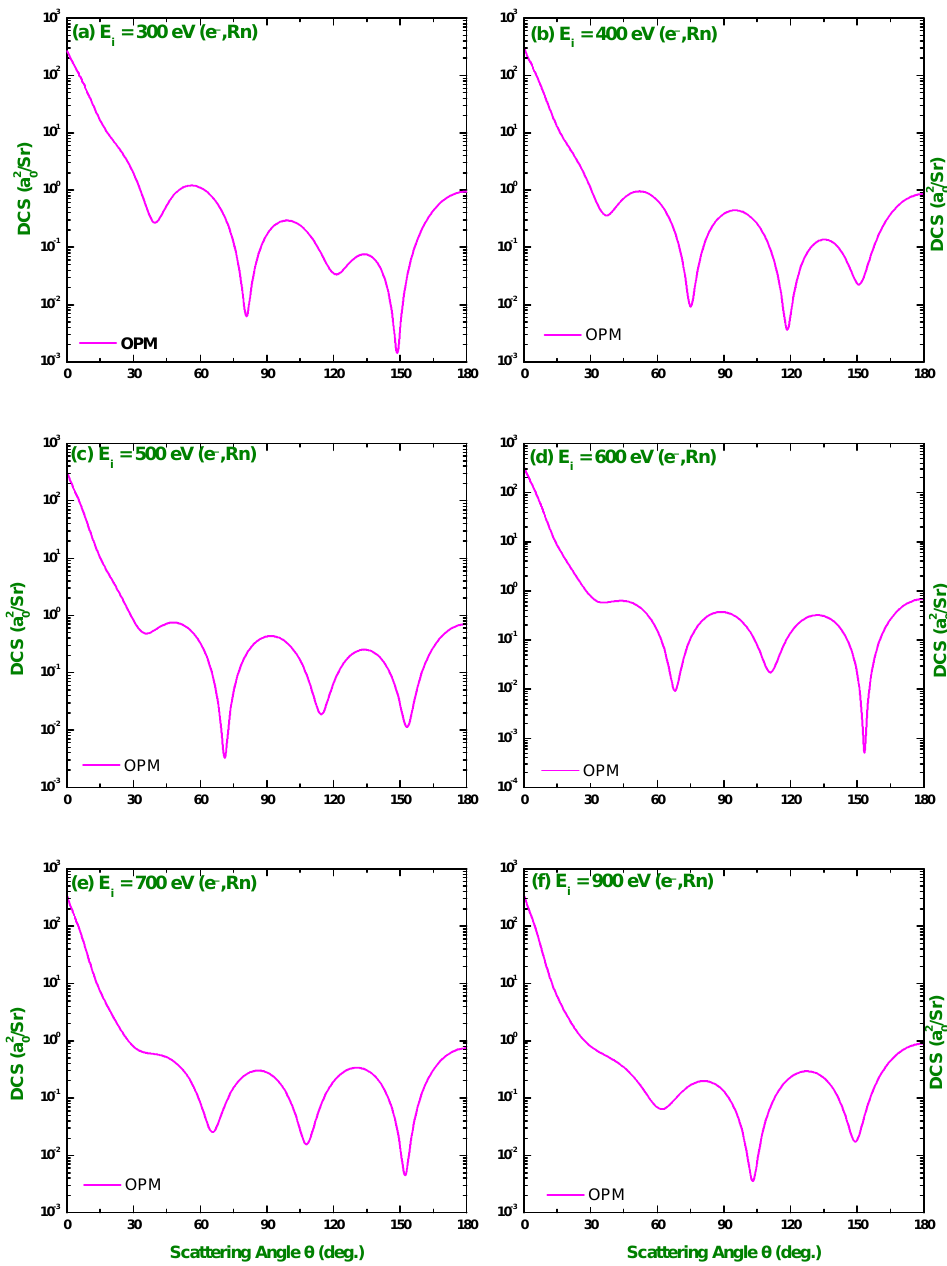
Figure 8. Angular dependence of the differential cross section of electrons scattering from 222 Rn at E i = 300, 400, 500, 600, 700 and 900